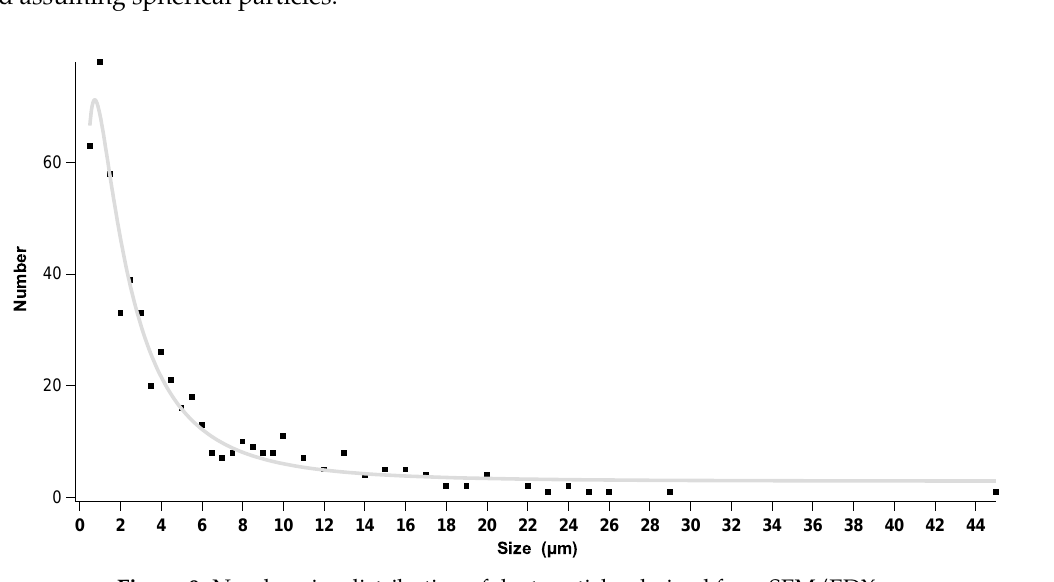
Figure 9. Number size distribution of dust particles derived from SEM/EDX